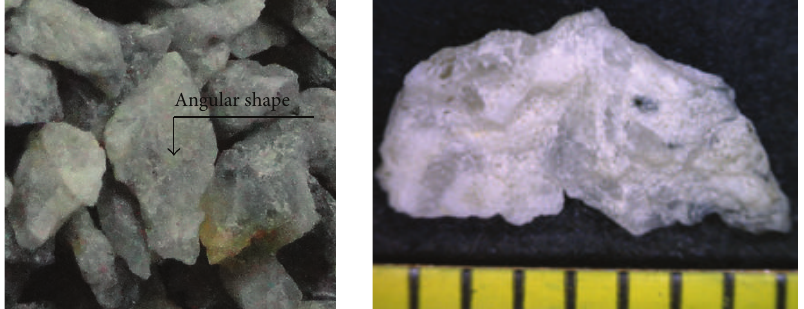
Figure 16: Shape of quarry dust particle (2.36 mm